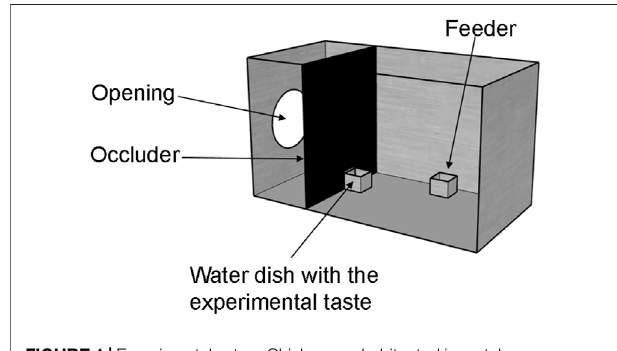
FIGURE 1 | Experimental setup. Chicks were habituated in metal cages with food and water ad libitum . Prior to the presentation of the experimental taste, chicks were water deprived for 45 min by removing their water dish throughanopeningintheoccluder.Then,anidenticalwaterdishwiththe experimental taste was presented for 10 minutes. A camera was placed above each cage to record chicks behavioural responses to the taste.